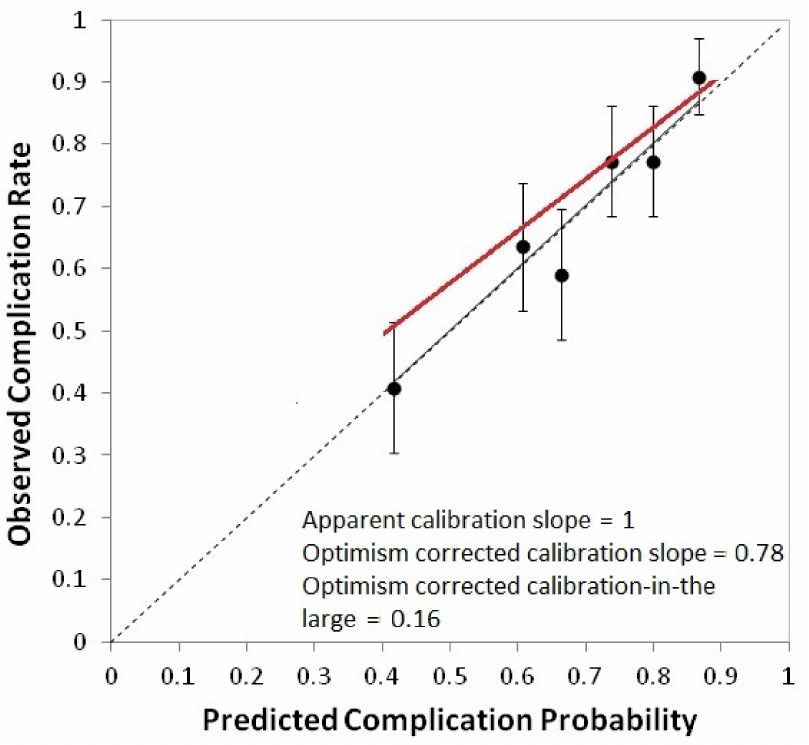
Figure 1. Calibration plot for the model for grade ≥ 2 acute salivary dysfunction in the nasopharyn- geal cancer cohort use for model development. Calibration plots present the rate of observed events in a group of patients ( y -axis) vs. the mean predicted probability for the same group ( x -axis). Groups of patients are ordered for increasing predicted probability. Error bars represent the confidence interval in observed frequencies calculated from proportions in the study population and based on a normal distribution of events. The dotted line is the identity line, identifying perfect calibration, the continuous black line is the apparent calibration line, and the red line is the calibration line after correction for optimism. Calibration slope and calibration-in-the-large are also reported.